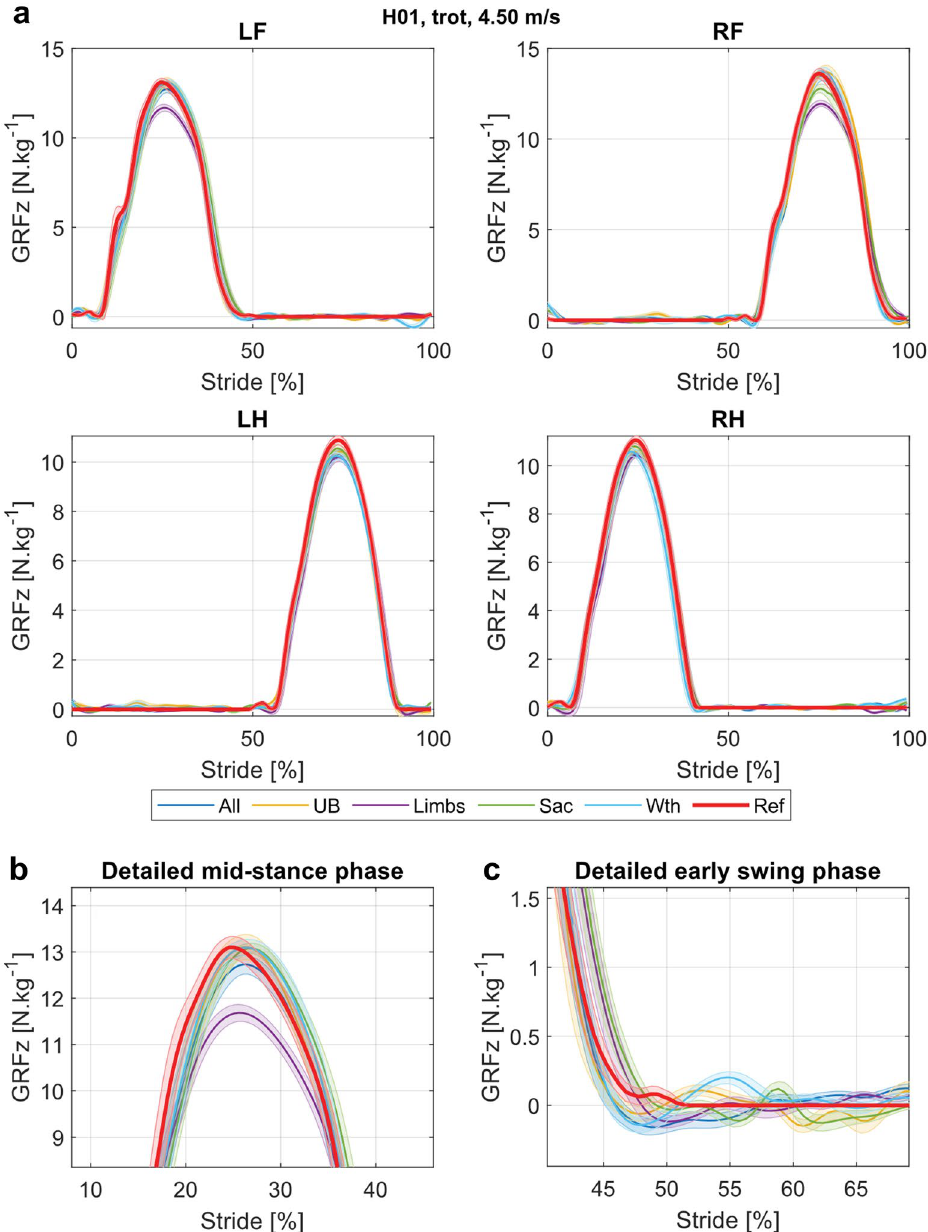
Figure 2. Example of GRFz curves predicted by the nodes sets for the trot data, at 4.50 m/s. ( a ) GRFz for all limbs. The average strides are displayed as a bold line and standard deviations are shown by thin lines and shaded areas. The reference curves are shown in red (Ref: TiF reference), the curves predicted by models trained with all nodes (All: head, withers, sacrum and limb nodes) in orange, with upper-body nodes (UB: head, withers and sacrum nodes) in yellow, with limb nodes (Limbs: limb nodes) in purple, with the sacrum node (Sac: sacrum node) in green and with the withers node (Wth: withers node) in light blue. LF left front, RF right front, LH left hind, RH right hind. ( b ) Detailed comparison of the predictions during the stance phase of the LF limb. ( c ) Detailed comparison of the predictions during the swing phase of the LF